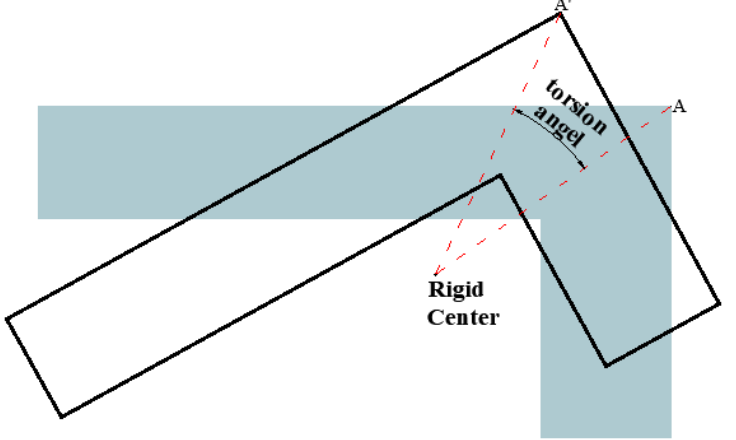
Figure 14. Schematic of the inter-story torsion angle.